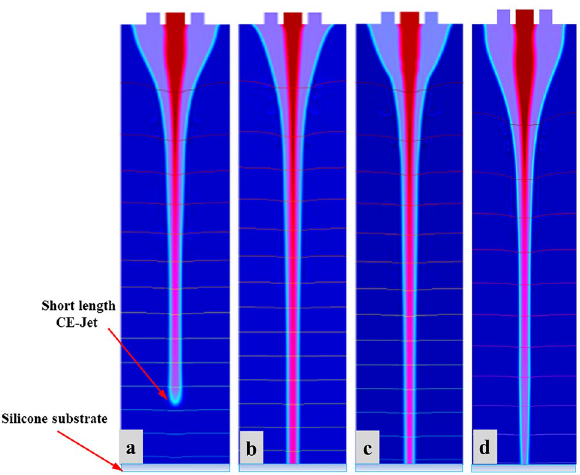
Figure 8. The specific morphologies of the simulated CE-Jet at different flow rates of inner solution ( a ) 300 nl/ min ( b ) 400 nl/min ( c ) 500 nl/min and ( d ) 600 nl/min.